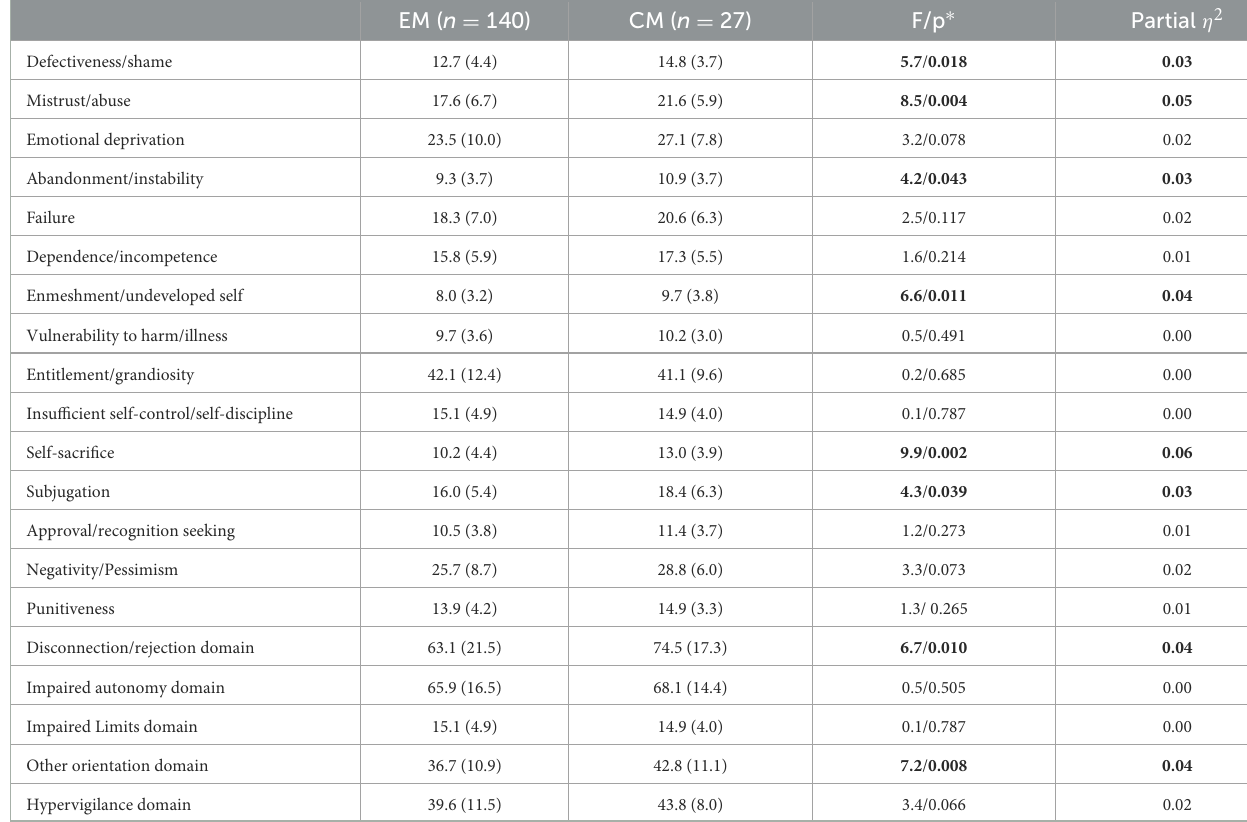
TABLE 5 Comparison of adolescents with episodic (EM) and chronic migraine (CM) in terms of early maladaptive schemas and schema